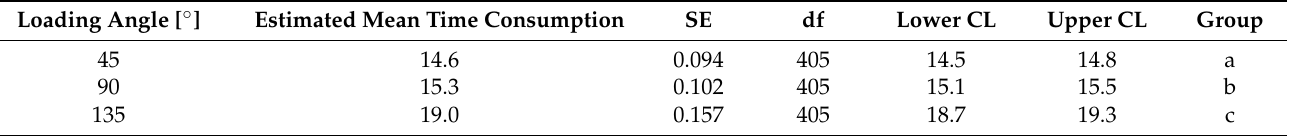
Table 3. Least-squares means of time consumption required for loading cycles for each group of loading angle